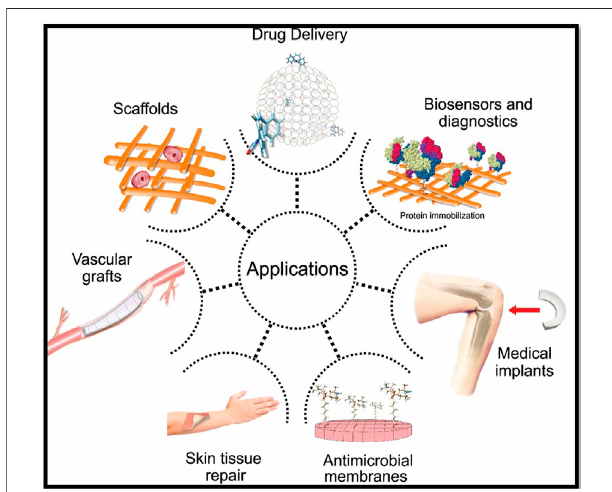
FIGURE 1 | Biomedical applications of nanoscale cellulose hydrogels. Figure reproduced from Toro et al. (2021) under Creative Commons Attribution (CC BY)